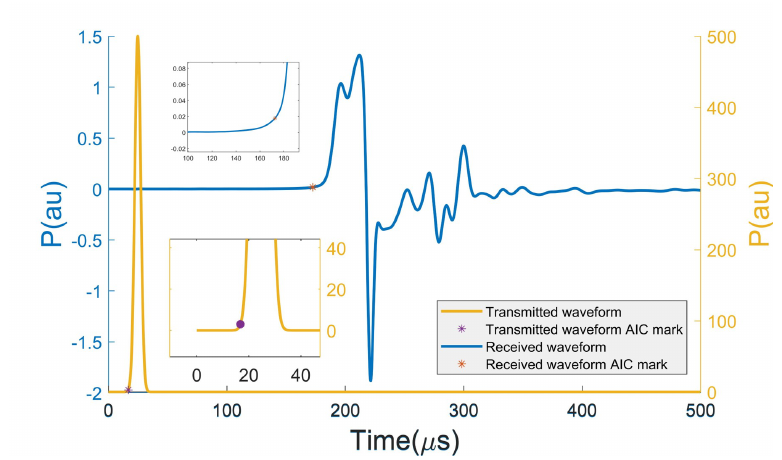
Figure 5. The transmitted waveform and the received waveform from transmitter No. 9 and receiver No. 15. The blue line is the received waveform corresponding to the left blue scale. The yellow line is the transmitted waveform corresponding to the right yellow scale. The position of the marker is calculated using AIC method, which marks the waveform is received/transmitted. The difference of the two positions is the traveltime of the signal, which is 155.75 µ s.